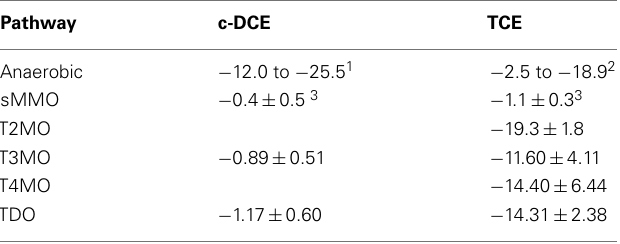
Table 3 | Enrichment factors ( ε ) expressed in ‰ for δ 13 C from degradation of cis -1,2-dichloroethene (c-DCE) and trichloroethene (TCE) by six degradative pathways as determined from this study and the literature: anaerobic reductive dechlorination, soluble methane monooxygenase (sMMO), toluene-2-monooxygenase (T2MO), toluene 3-monooxygenase (T3MO), toluene 4-monooxygenase (T4MO), and toluene 2,3-dioxygenase